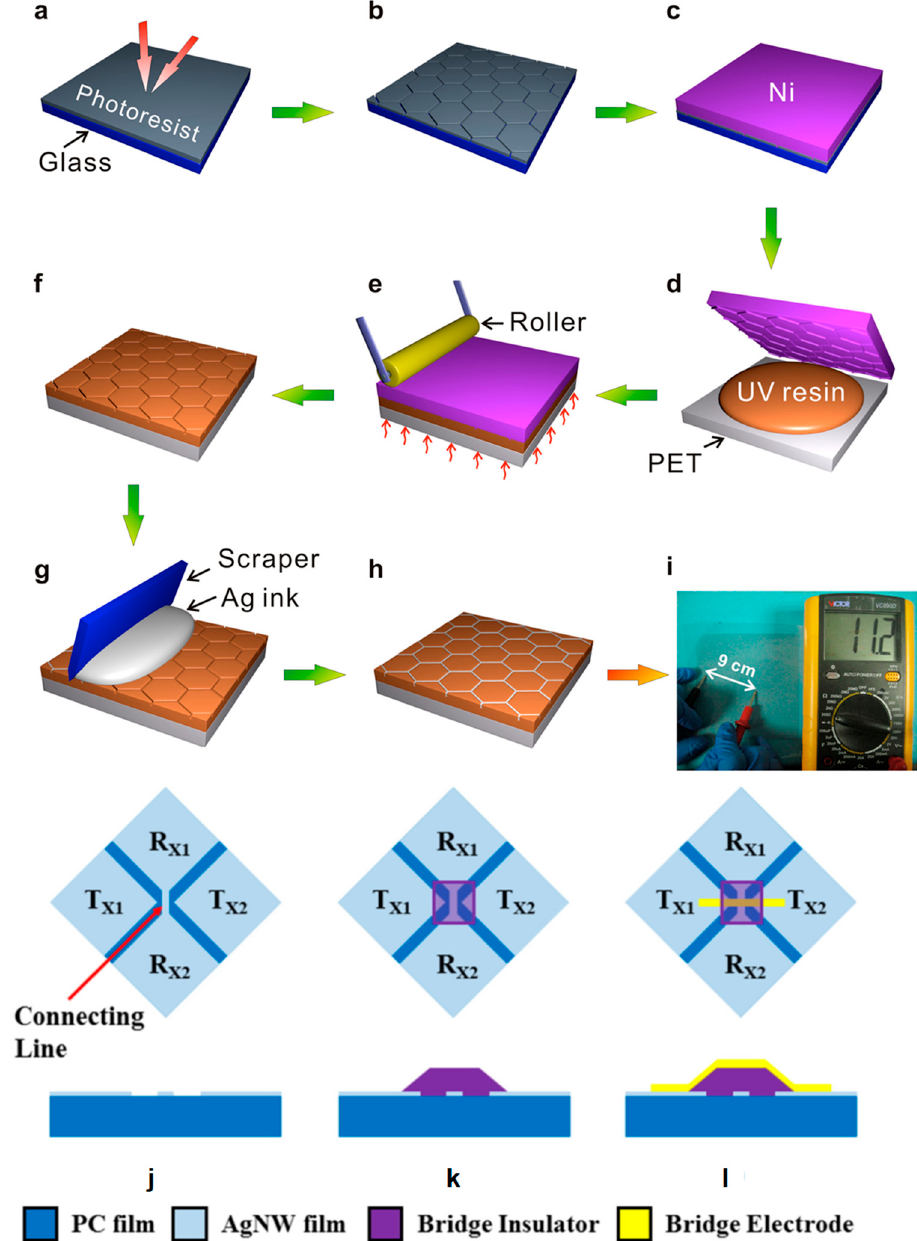
Figure 3. ( a – i ) Schematic illustration of the fabrication steps of an embedded Ag network on PET substrate. ( a ) Fabrication of a hexagonal pattern on the photoresist on a glass substrate using pho- tolithography. ( b ) Development of hexagonal photoresist mold. ( c ) Pattern transfer to a Ni mold using electroforming. ( d ) Dispersing UV resin on a PET substrate. ( e ) Mold transfer with UV nanoimprinting lithography. ( f ) Hexagonal pattern formation with plasma treating. ( g ) Dispersing the nanostructured Ag ink and scratching by Ag paste scratch technology. ( h ) Sintering and cleaning of the embedded Ag networks. ( i ) Resistance value of the patterned Ag networks. Reproduced with permission from Ref. [31]. Copyright 2014, American Chemical Society. ( j – l ) All processes of fabricat- ing a flexible and transparent patterned Ag nanowire electrode-based touch panel. ( a ) Patterning Ag nanowire electrode, ( b ) forming a transparent bridge insulator (SU-8), and ( c ) forming a bridge electrode (AZO) over the bridge insulator. Reproduced from Ref. [30] under the Creative Commons Attribution 4.0 International (CC BY 4.0)